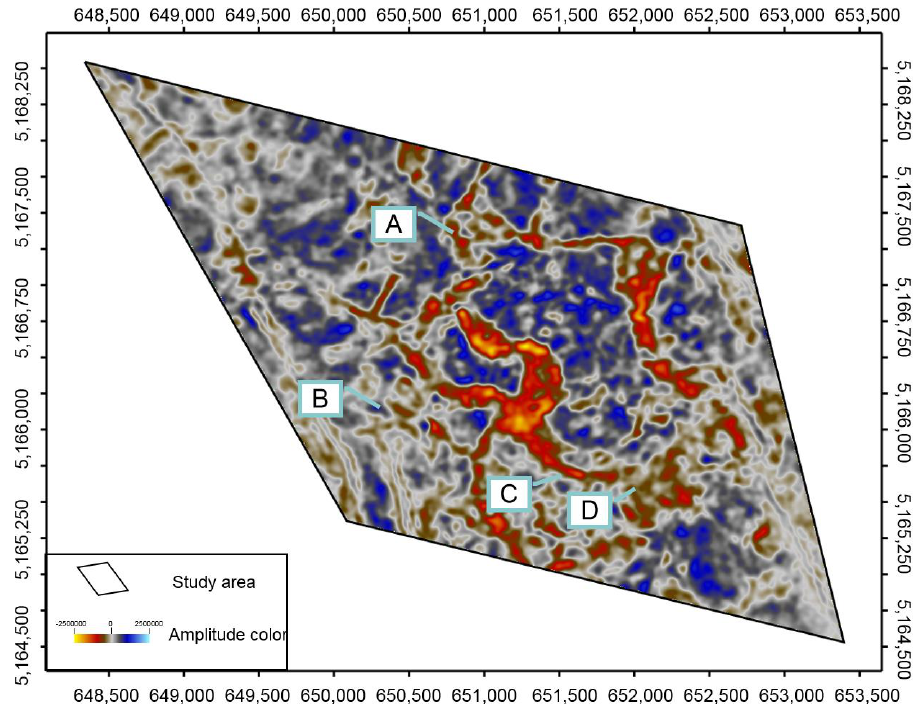
Figure 5. Dominant amplitude of layer G I 2 . A, B, C and D represent four different typical amplitude variation locations.